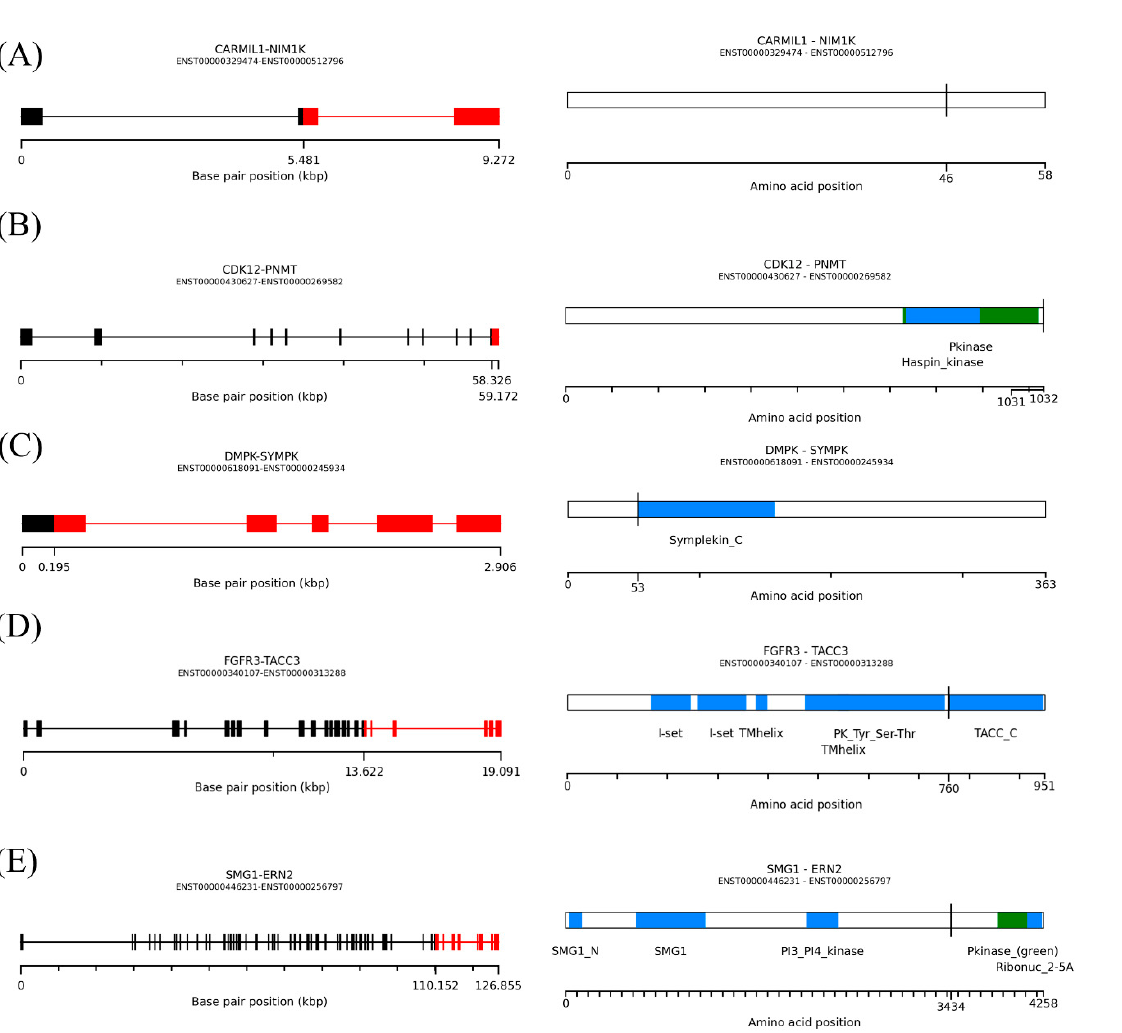
Figure 4. Predicted structures of kinase gene fusions. ( A ) CARMIL1 - NIM1K , ( B ) CDK12 - PNMT , ( C ) DMPK - SYMPK , ( D ) FGFR3 - TACC3 , and ( E ) SMG1 - ERN2 .